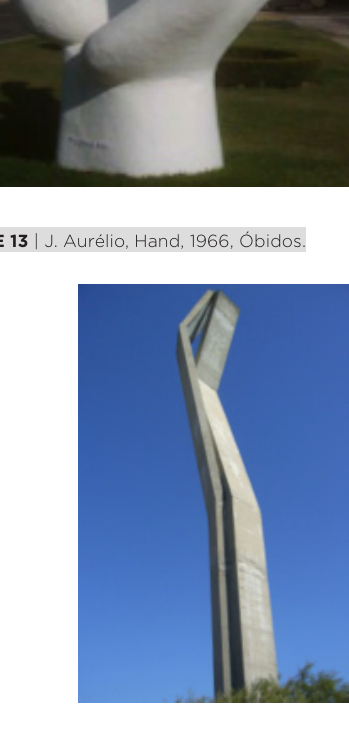
FIGURE 14 | F. Conduto, Troia,